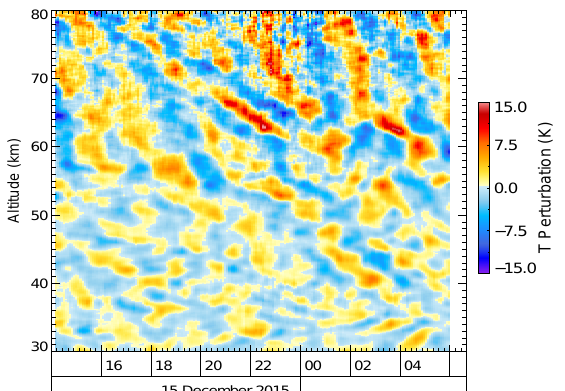
Figure 1. Gravity wave-induced temperature perturbations observed by Rayleigh lidar on 15/16 December 2015 above Sodankylä, Finland. The temperature measurements are filtered with a 3-h running mean to highlight signatures of gravity waves with periods in the range of approximately 1 to 5 h. The temporal and vertical resolutions are 30 min and 1km,